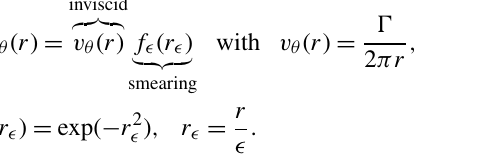
Figure 1. Distribution of the tangential velocity component in a plane orthogonal to an infinite vortex line (along x ) obtained from either an inviscid or viscous (Lamb–Oseen) theoretical vortex and an actuator line (AL) CFD